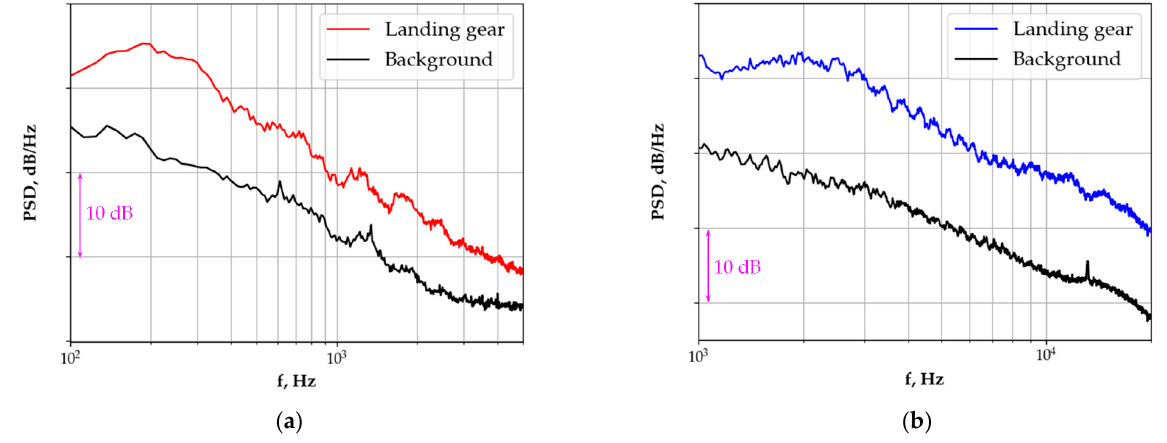
Figure 10. The parts of noise spectra from Figure 9 used for comparison of small-scale and full-scale data: ( a ) full-scale model in FL-17; ( b ) small-scale model in AC-2 TsAGI.